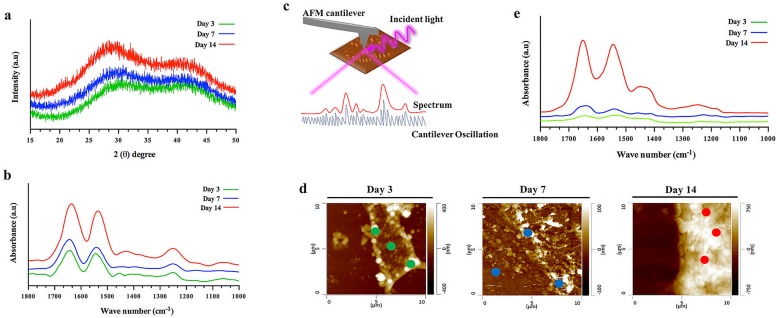
Physicochemical characterization of the SF hydrogel after incubation in PBS at 37°C for 3, 7 and 14 days.(a) XRD patterns of the SF hydrogels. (b) ATR-FTIR spectra of the SF hydrogels. (c) Schematic illustration of nanoscale IR spectroscopy using AFM-IR: IR pulses are emitted in the sample increasing the local absorption on SF nanofibrils acquired by the AFM cantilever tip, corresponding to the absorption spectroscopic peaks. (d) Tapping-mode AFM nano-images (10 μm x 10 μm), and (e) IR nano-spectra of the SF hydrogels obtained by measuring the samples at different points selected by the AFM tip, corresponding to the absorption spectroscopic signatures and indicated as green, blue and red points.